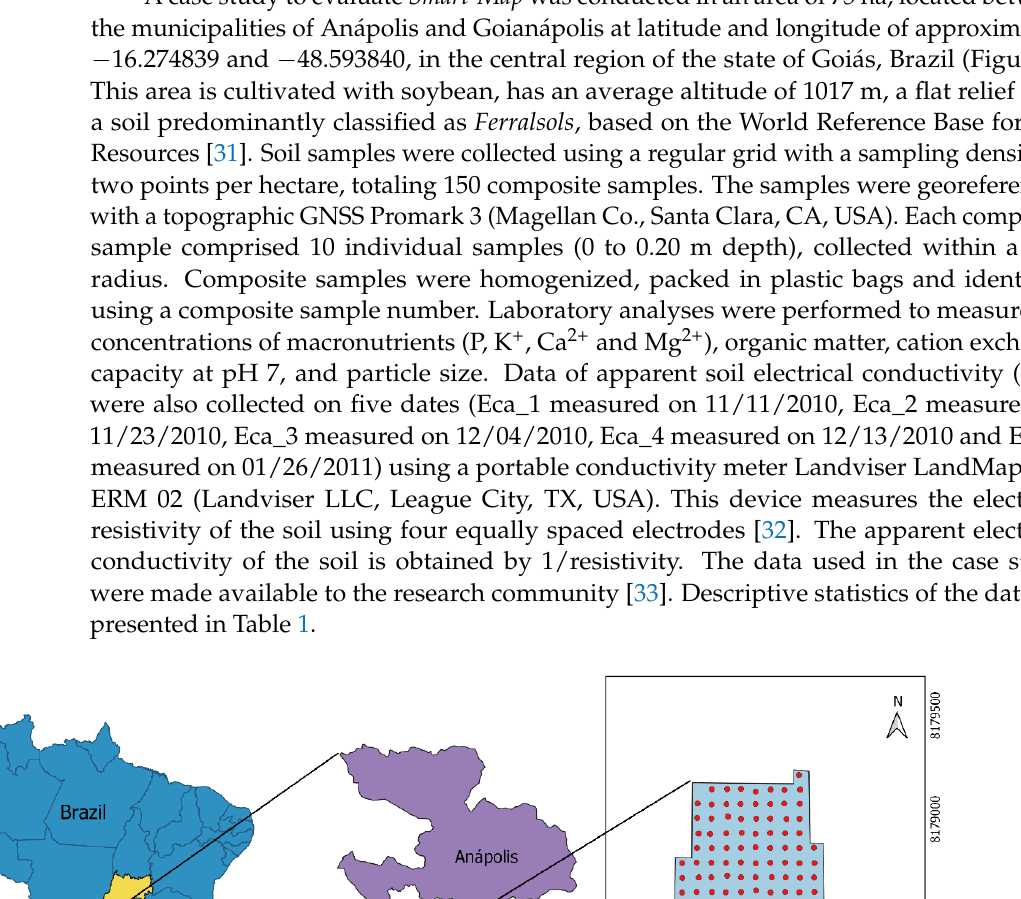
Figure 2. Graphical User Interface of Smart-Map. ( a ) Interpolation by OK. ( b ) Interpolation by SVM .